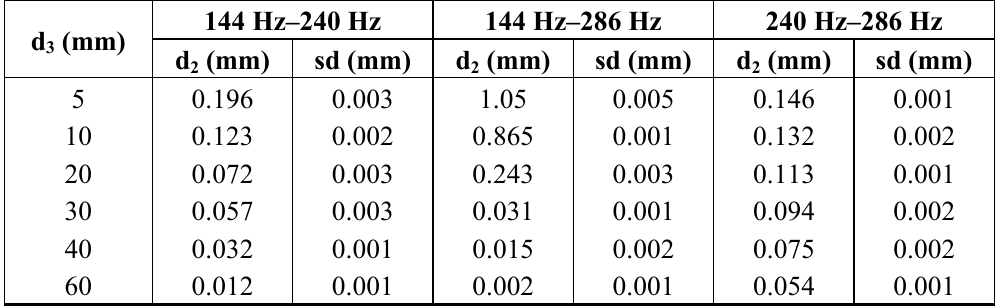
Table 5. Results of the measurement of the displacement d proximal to the excited oscillator at different distances d